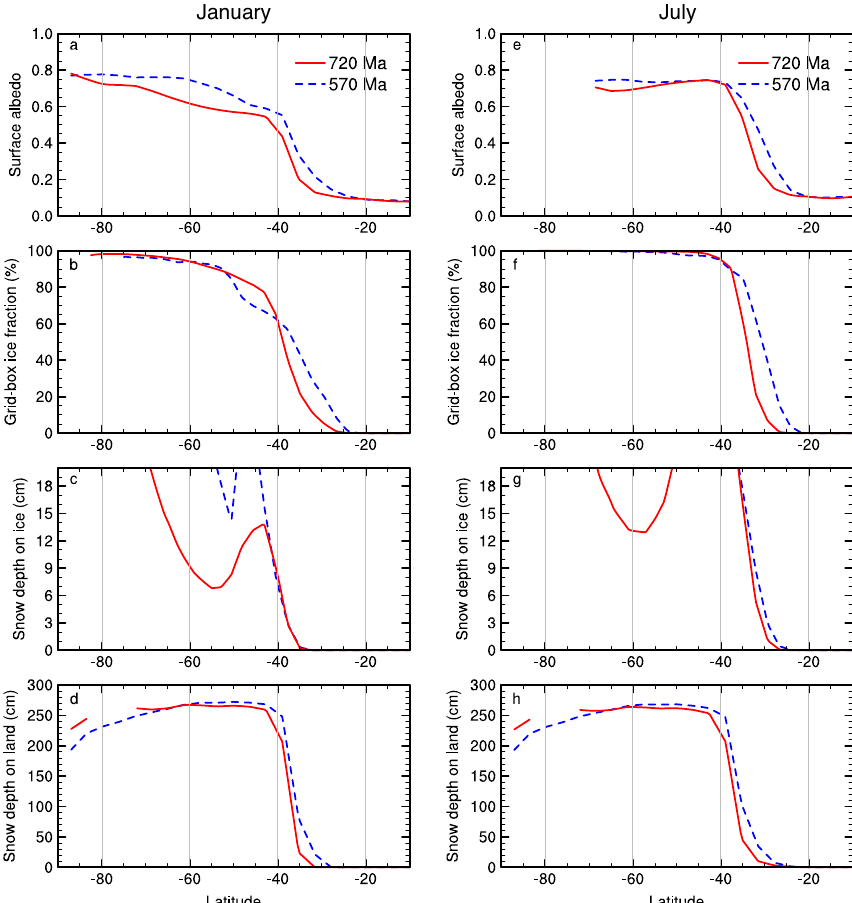
Fig. 11. Monthly mean surface albedo, grid-box sea-ice fraction, snow depth on sea ice and snow depth on land during January (left column) and July (right column) for both the 720Ma and 570Ma continental configurations. Note that the snow depth on sea ice is shown only up to 20 cm in order to make its seasonal variation around the 60 ◦ S latitude more evident. The results are averaged over the last 100 yr of the simulations; TSI = 0.94TSI 0 , τ = 0 . 12, p CO 2 = 140 ppmv for both of the